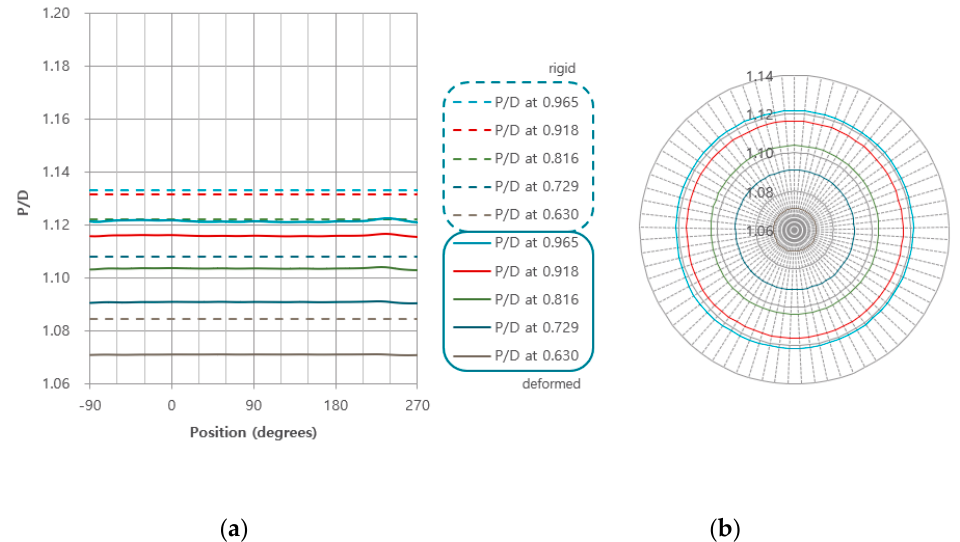
Figure 9. Pitch distribution changes of model 5 in the non-cavitating flow: ( a ) pitch distribution change according to the blade position, ( b ) radial chart of pitch distribution of composite propeller.